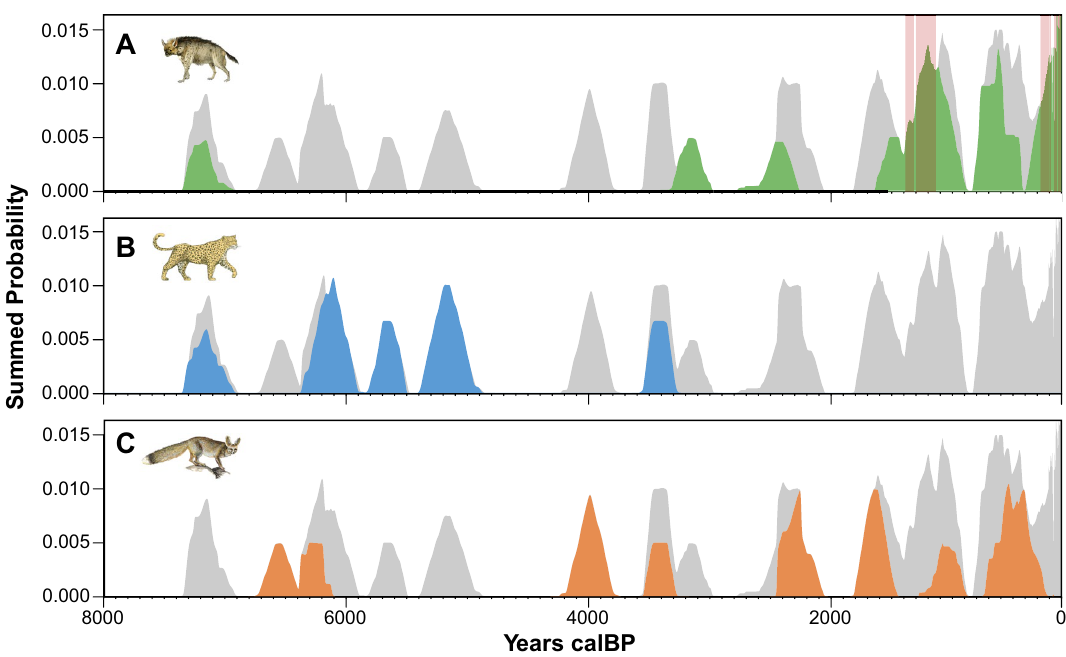
Figure 5. Summed probability density distribution of radiocarbon dates for each taxon. Significant deviations ( p < 0.05) in the distribution of dates are highlighted with red bands, as is the case for hyenas ( A ). The dates are homogeneously distributed in the case of leopards ( B ) and foxes ( C